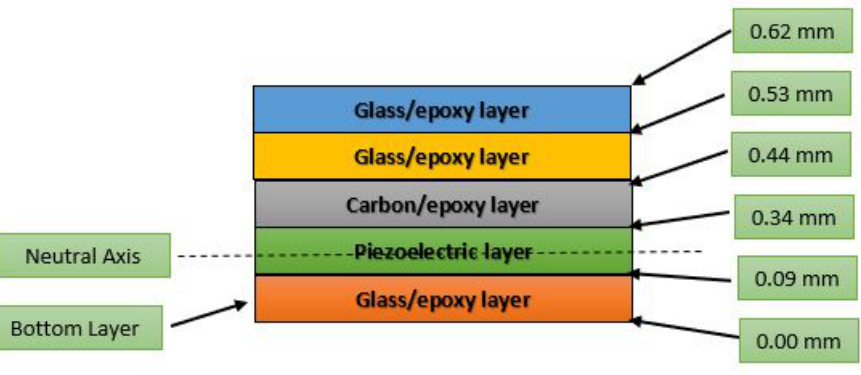
Figure 19. Plate-type mechanism-based embedded PEH schematic.